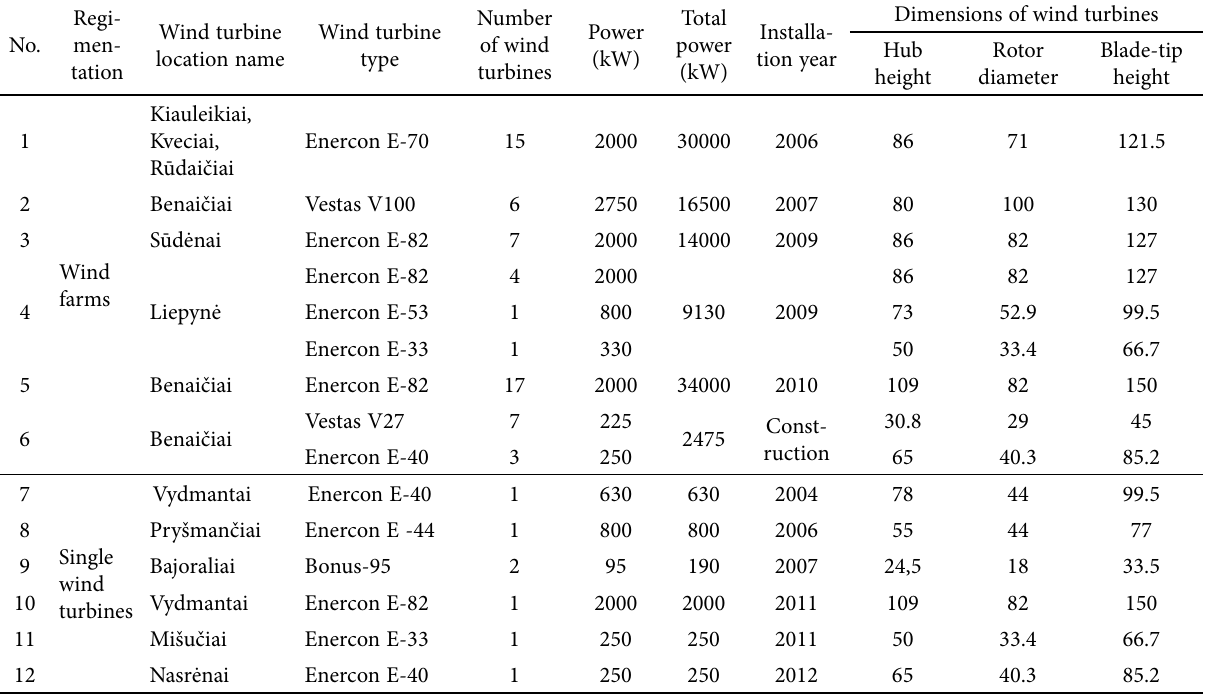
Table 1. Wind turbines located in Kretinga region and their technical – visual parameters Regi- No.